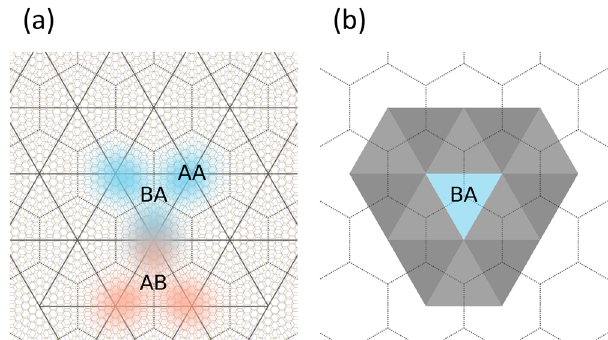
Fig. 1 Visualization of Wannier states (WSs), AA, and AB/BA sites in twisted bilayer graphene. a An example of a typical moiré pattern formed by a system with a twist angle of 6°. The moiré unit cells are delimited by the honeycomb lattice, and its dual triangular lattice is also shown. The blue and red blobs schematically represent the shape of Wannier orbitals on the BA and AB sublattices, respectively, with one overlapping charge lobe. b Schematic representation of the central WS in ( a ) as a blue triangle, where the vertices of the triangle correspond to the three charge lobes. The gray triangles show those WSs which have at least one lobe overlapping with the central blue WS; in other words, they share vertices with the central